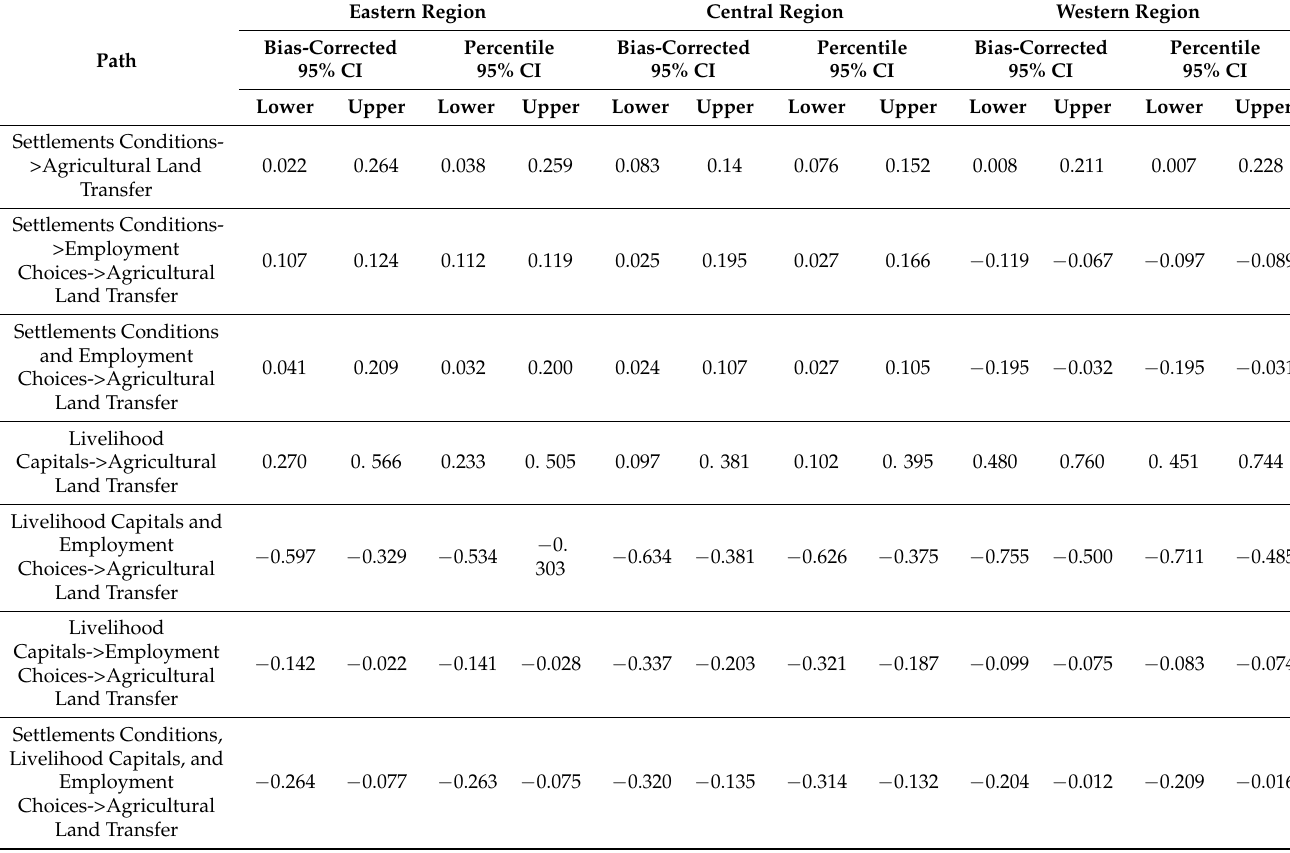
Table A7. Standardized bootstrap moderator–mediator test of the indifference